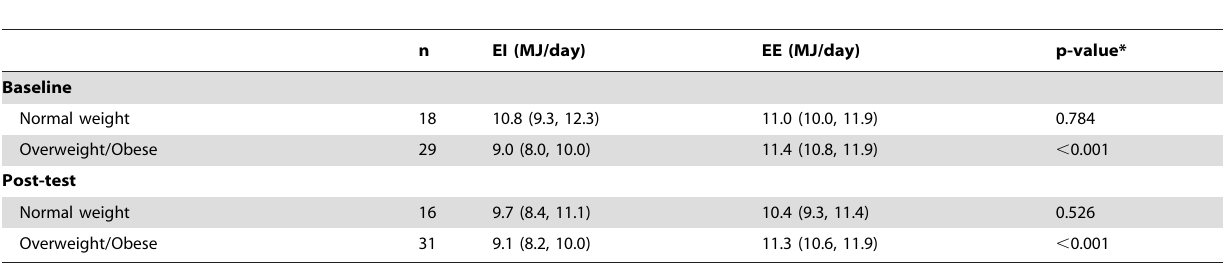
Table 2. Self-reported energy intake (EI) and measured energy expenditure (EE) among normal weight and overweight/obese